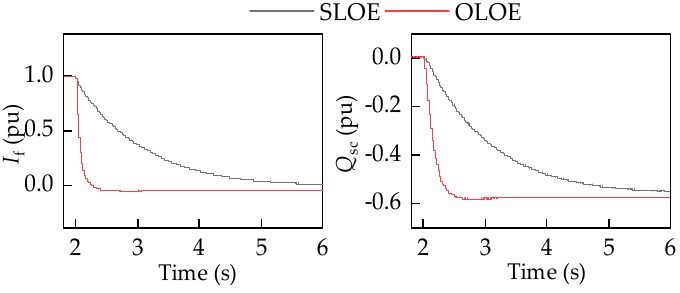
Figure 3 . Quantities of SC during loss of excitation (LOE). Figure 3. Quantities of SC during loss of excitation (LOE).